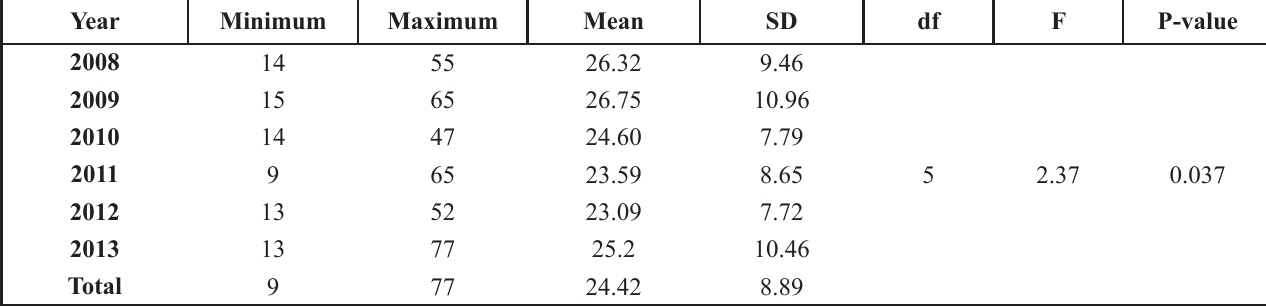
Table 3. Suicide rate based on the average of age during 2008-2013 according to emergency unit records of Shahid Mohammadi Hospital